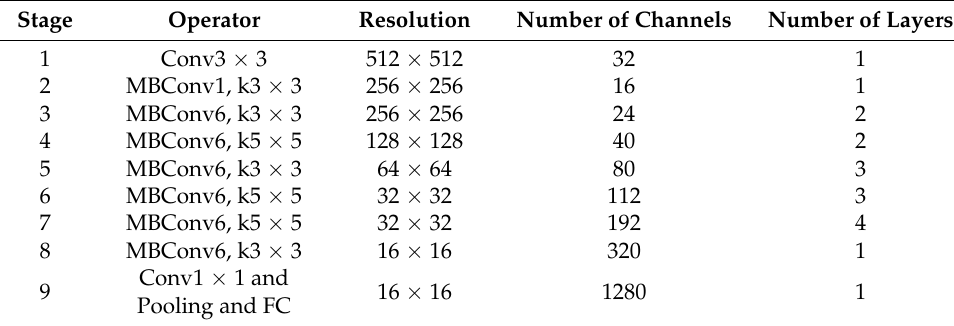
Table 2. Parameters of the EfficientNet-B0 network used in our work. Stage